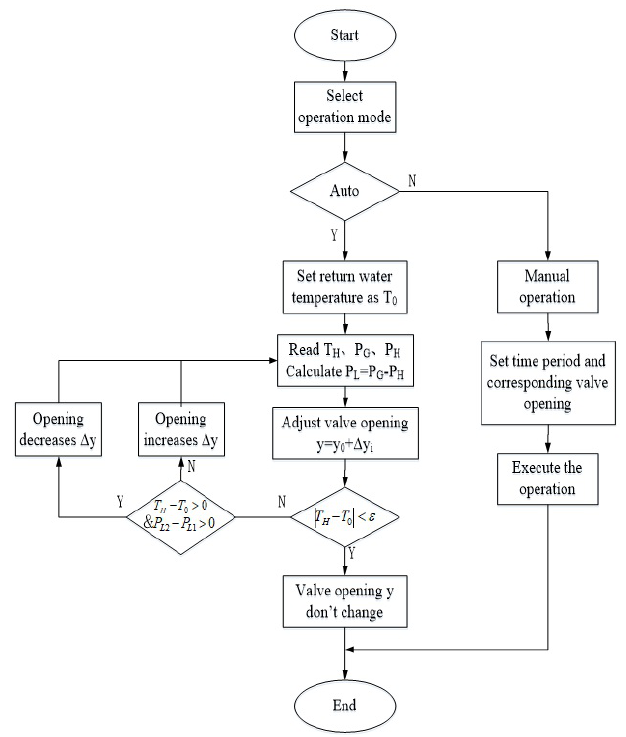
Fig. 6 Program design flow chart.